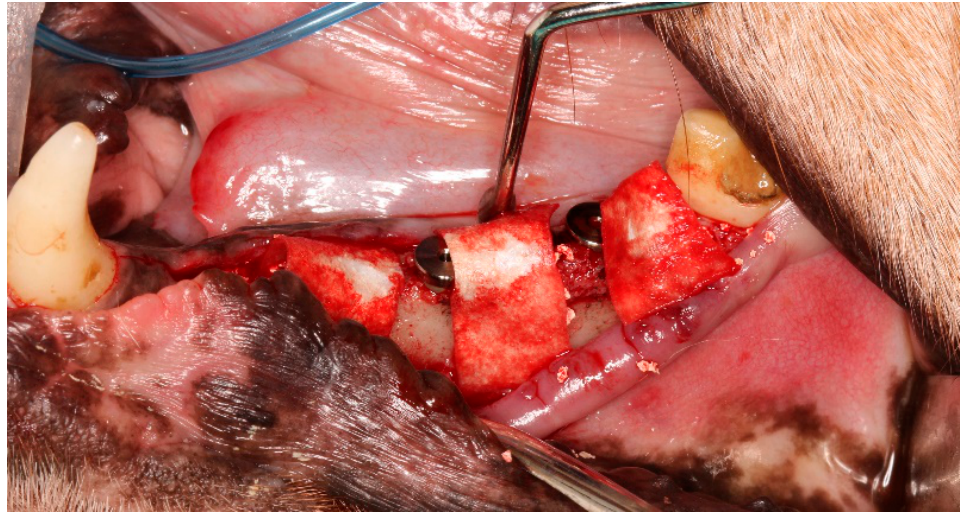
Figure 4. Guided bone regeneration (bone graft and membrane) of the induced 2 mm and 5 mm defects.